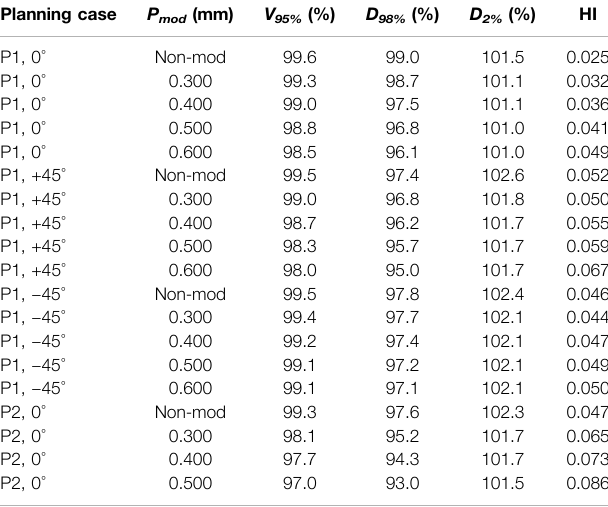
TABLE 4 | Dosimetric indices for proton treatment plans for P1 and P2 with ρ range of 0.1 – 0.5 g/cm 3 and different planning parameters for each for the two